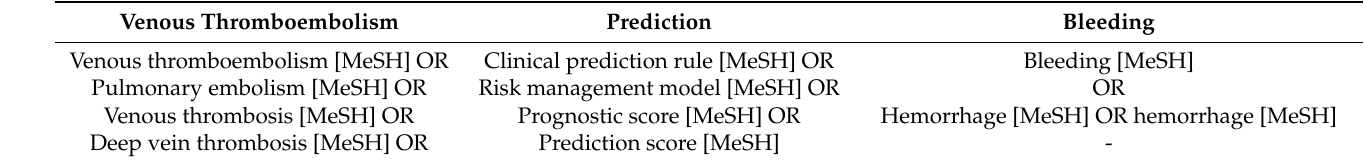
Table 2. Electronic search strategy for PubMed research through 20 September 2021 with no date